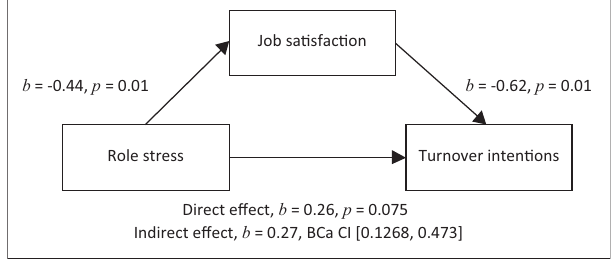
FIGURE 2: Diagram of the job satisfaction mediation model with regression coefficients, indirect effects and bootstrapped confidence intervals.